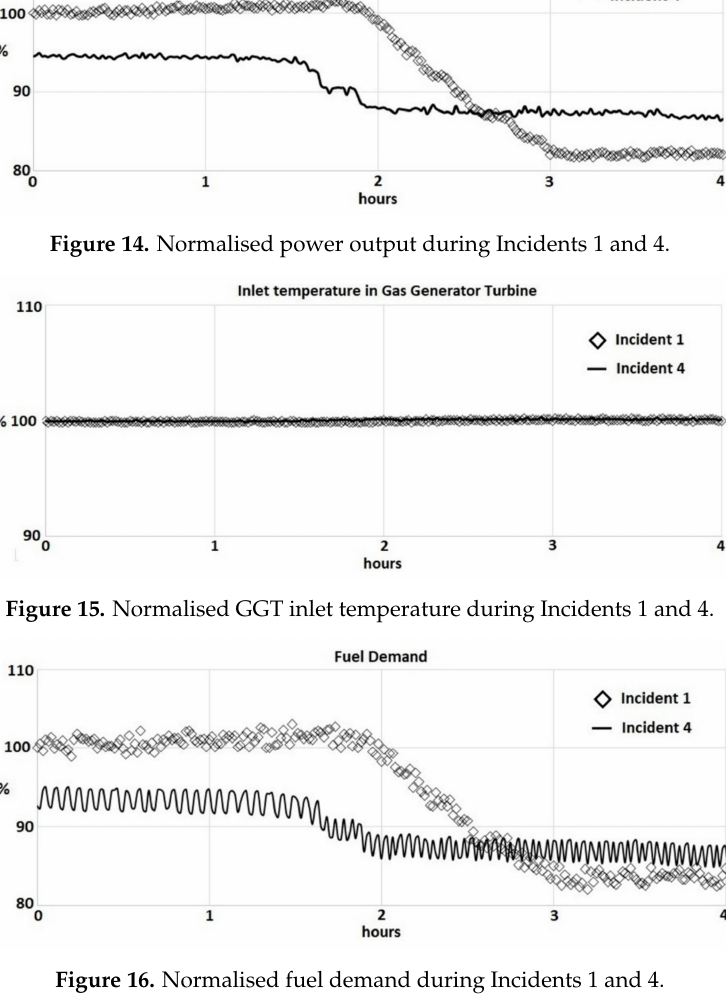
Figure 16. Normalised fuel demand during Incidents 1 and